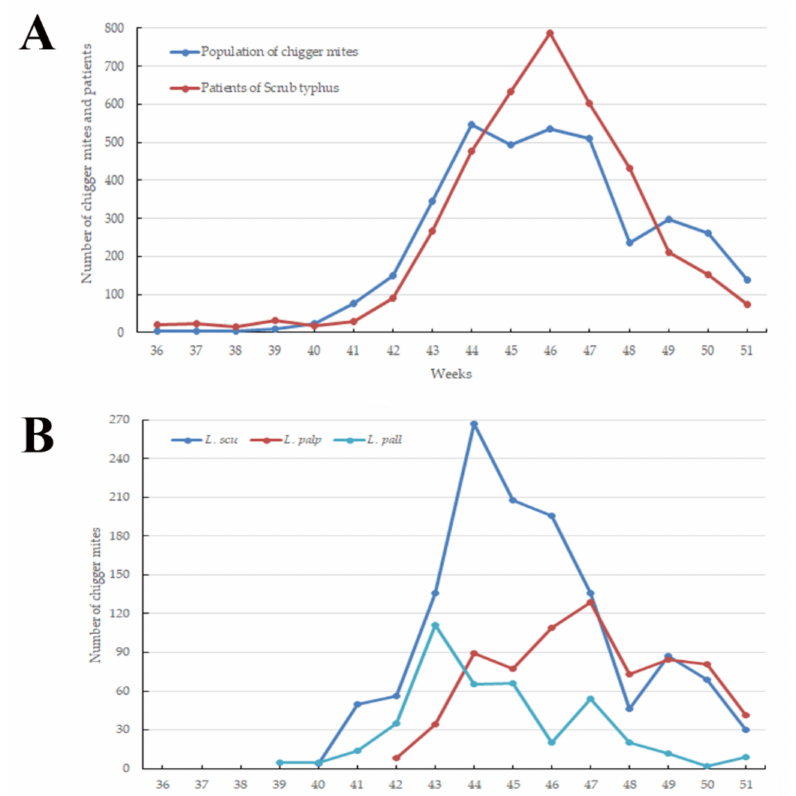
Figure 1. Weekly fluctuations in the population of chigger mites and patients of tsutsugamushi disease ( A ), and the abundance of the three predominant chigger mite species carrying Orientia tsutsugamushi ( B ) collected from the sticky traps in the Republic of Korea between the 36th and 51st weeks in 2020. L. scu, Leptotrombidium scutellare; L. palp, Leptotrombidium palpale; L. pall, Leptotrombid- ium pallidum